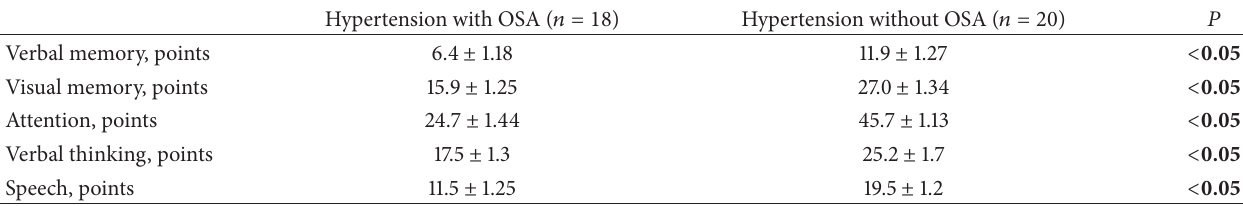
Table 4: Cognitive functioning of hypertensive adolescents according to absence or presence of